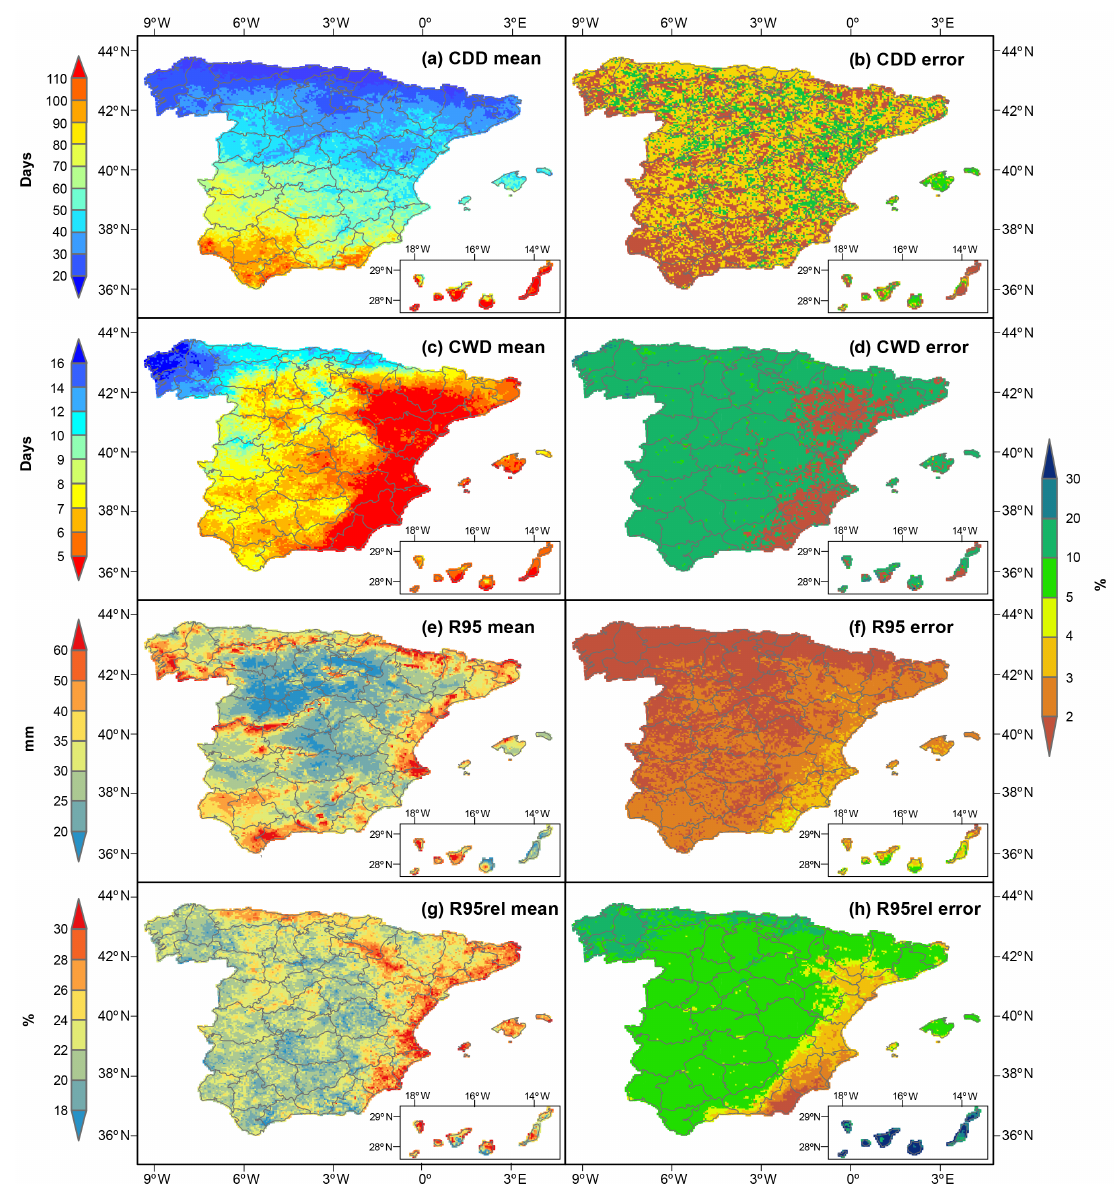
Figure 7. Daily extreme precipitation indices (a, c, e, g) and their uncertainty (b, d, f, h) . CDD: maximum consecutive dry days; CWD: maximum consecutive wet days; R95: 95th percentile of precipitation; R95rel: contribution of precipitation over 95th